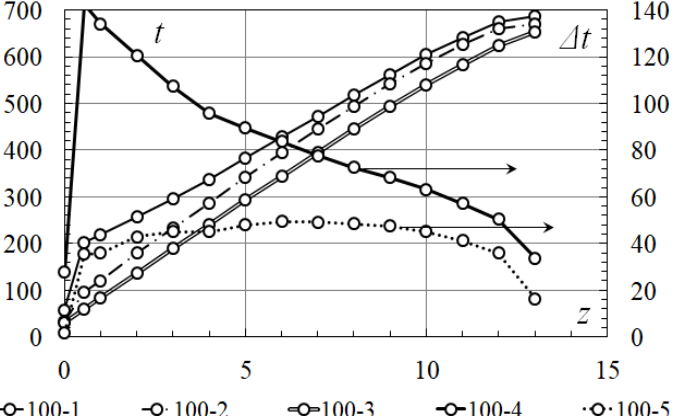
Figure 7. Change of the temperature t [ ◦ C] and the temperature head ∆ t [ ◦ C] by the length of the duct